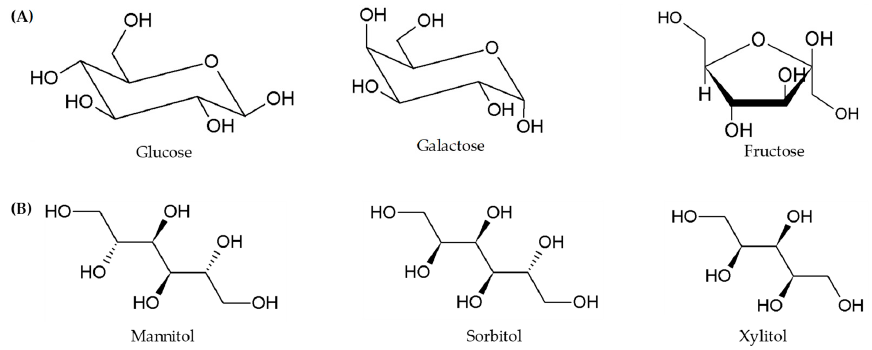
Figure 2. Examples of FODMAPs’ chemical structures. ( A ) Monosaccharides; ( B ) polyols.